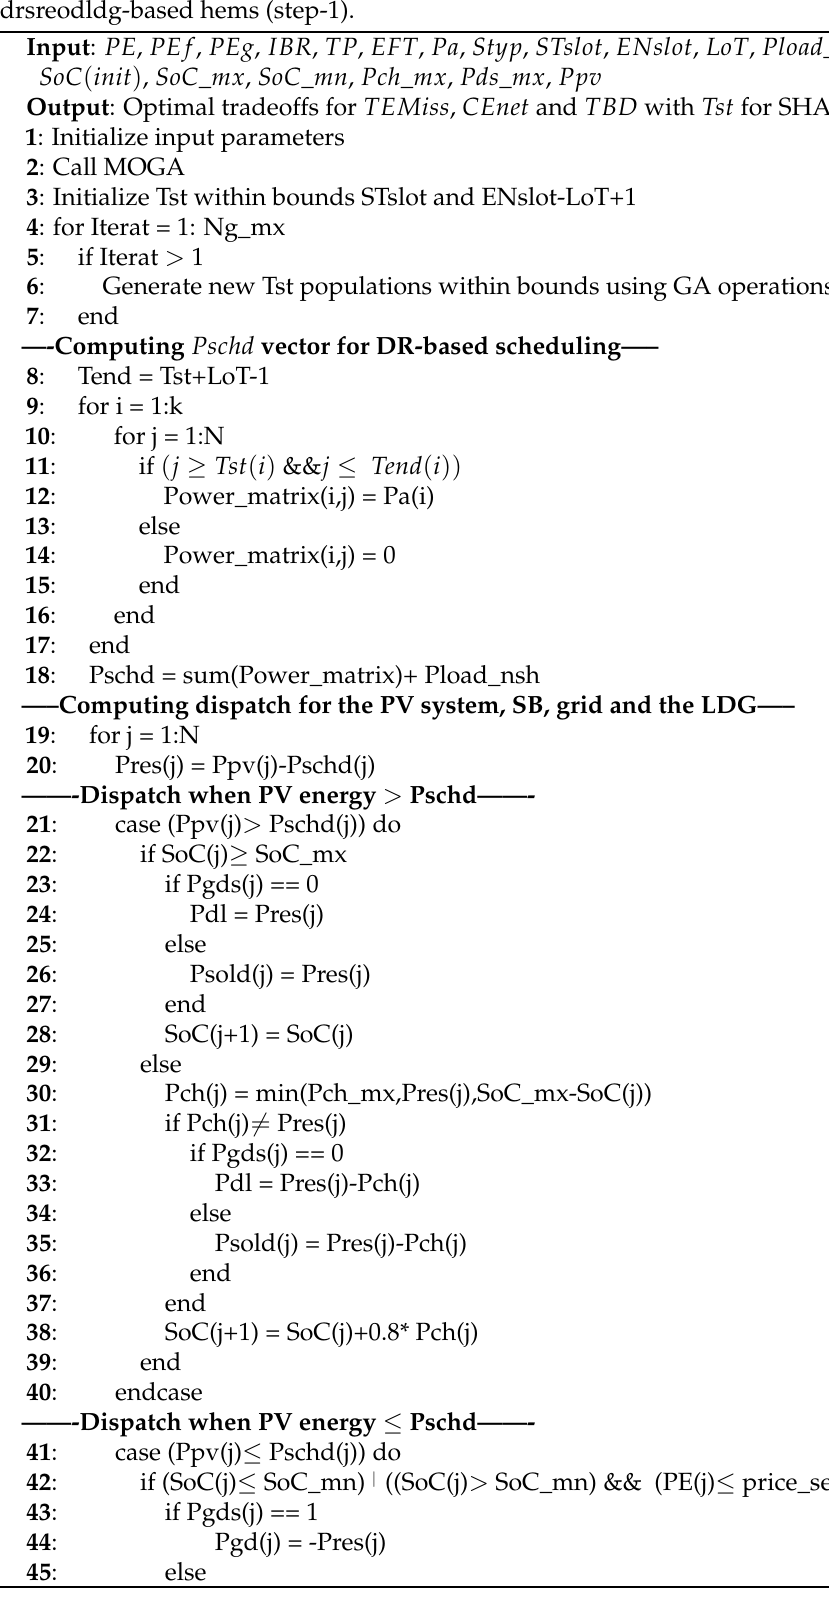
Algorithm 1: Algorithm to generate operating schemes and the primary tradeoffs for drsreodldg-based hems